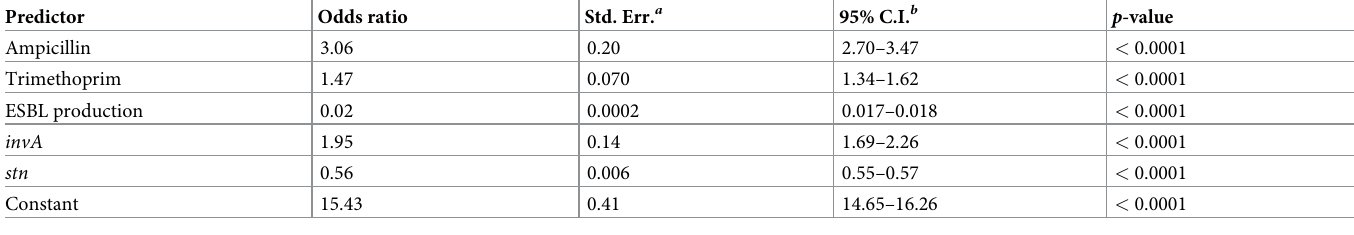
Table 8. Logistic regression model of the association between Salmonella resistance to sulfamethoxazole and resistance phenotype, resistance gene, and virulence genes ( n = 126) classified by type of samples. Predictor Odds ratio